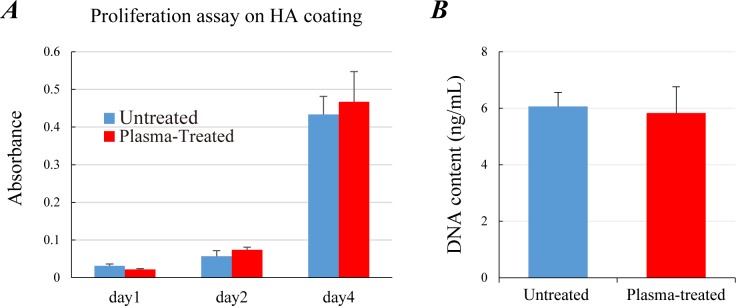
Cell proliferation on HA surfaces in non-osteogenic culture.(A) WST-8 assay for MC3T3 cultured on HA-coated plates at day 1, 2 and 4. Blue and red lines denote untreated and plasma-treated groups, respectively. (B) DNA content of IP-CHA discs (φ5 mm × h2 mm) combined with rat MMCs. The MMCs/IP-CHA composites were cultured in non-osteogenic growth medium for 7 days. Data were represented as mean ± SD of 2 independent triplicate experiments.